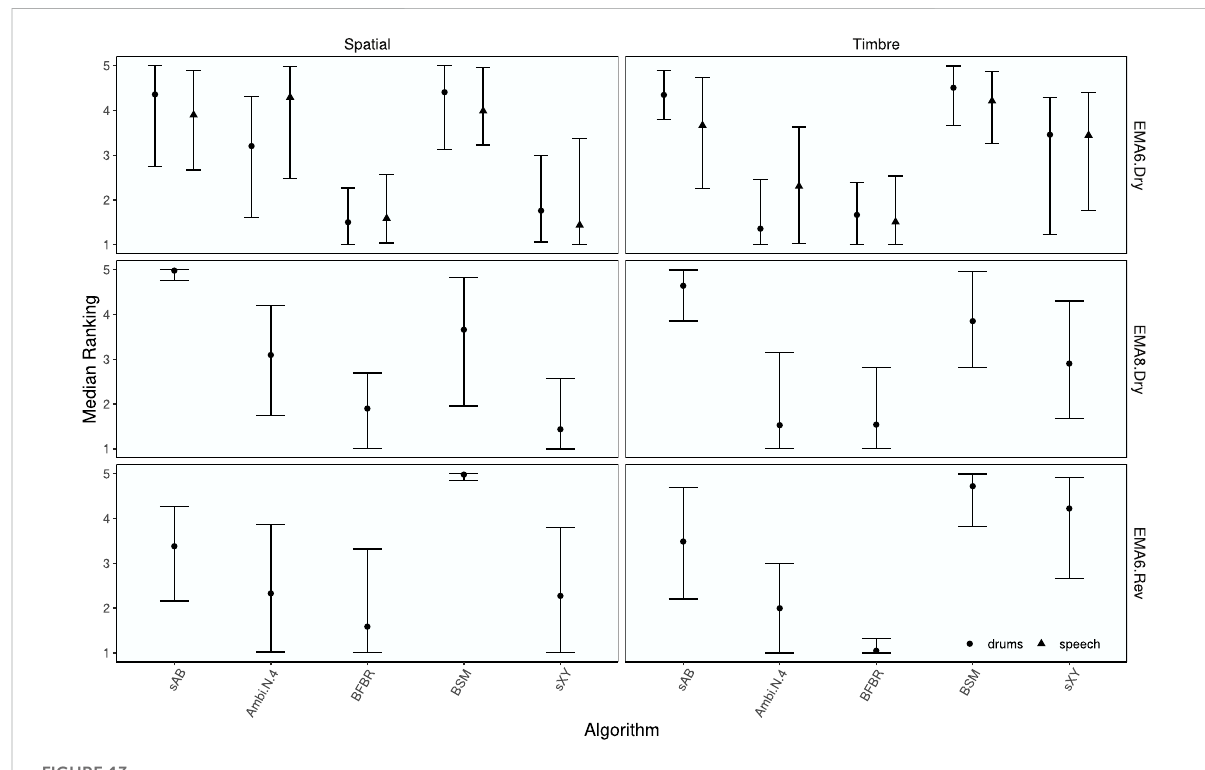
FIGURE 13 EXPERIMENT1: Median ranks for each rendering by attribute, array con fi guration, test signal, and rendering approach. Points represent median rank and error bars depict the 89% highest density credible